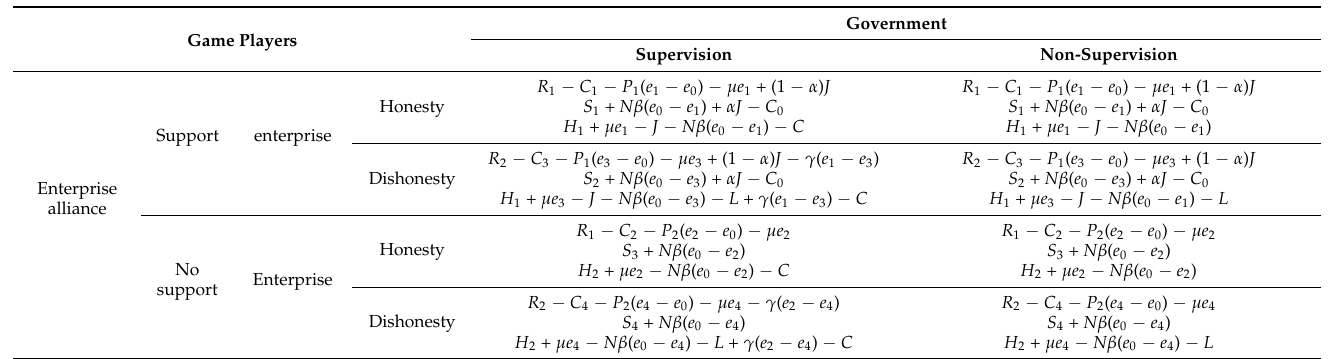
Table 2. Income matrix of government, enterprises and alliance.